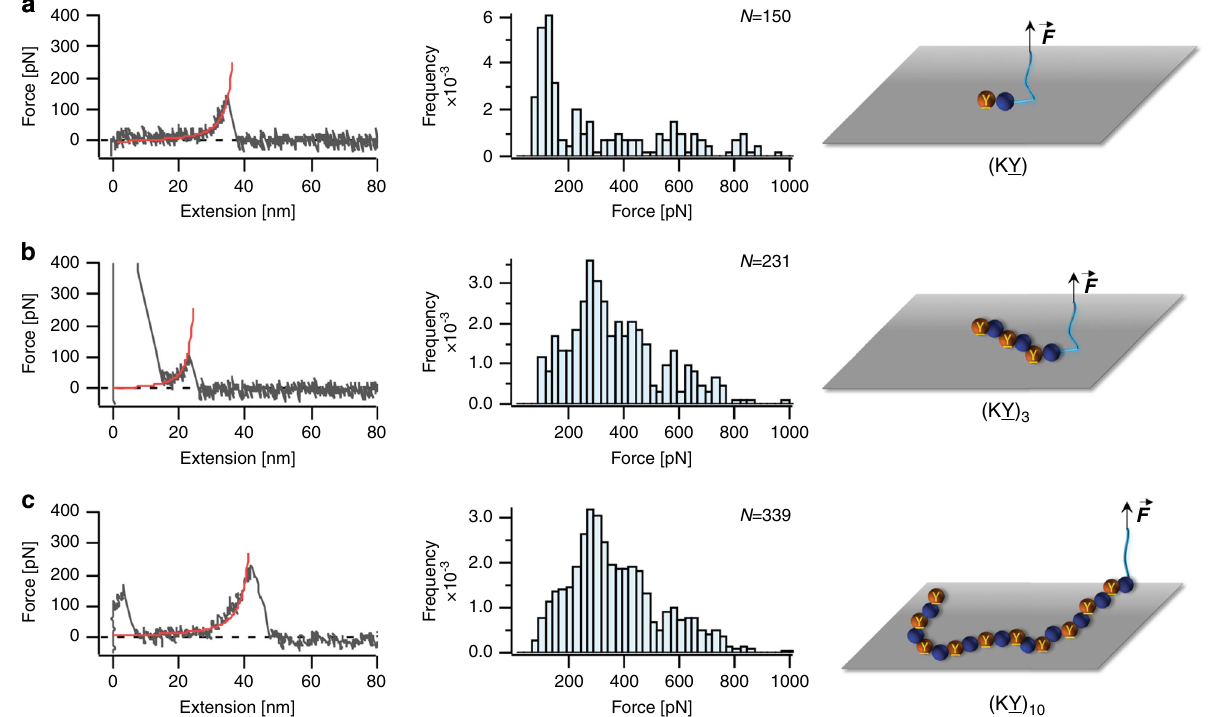
Fig. 3 SMFS results for the interaction of (KY), (KY) 3 , and (KY) 10 peptides with TiO 2 . Representative F – X curves (left column) and rupture force distribution (middle column) are shown for a (KY), b (KY) 3 , and c (KY) 10 . N values represent the total number of rupture events used to plot the histograms. The red lines on the F – X curves correspond to WLC fi tting. Right column shows schematic illustration of the peptides interacting with the substrate. Source data are provided as a Source data fi